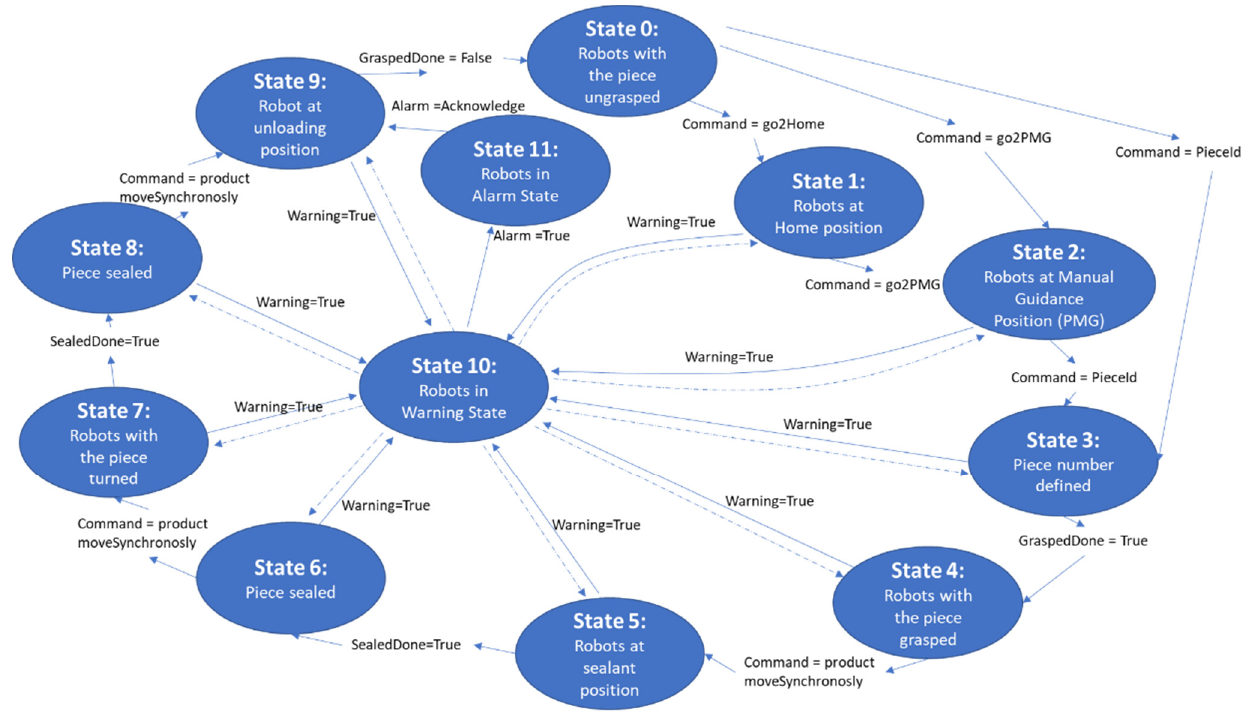
Figure 6. Bloc diagram of the state machine.